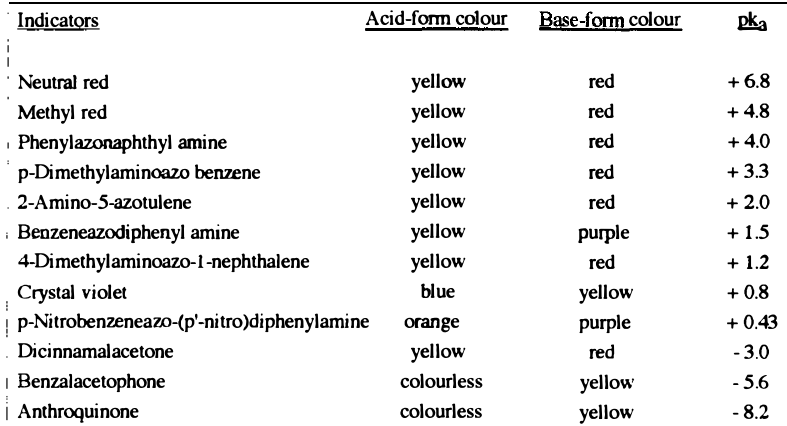
Table 1. Basic indicators used for the measurement of acid strength